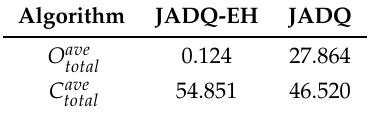
and C ave under scenario 2. total total